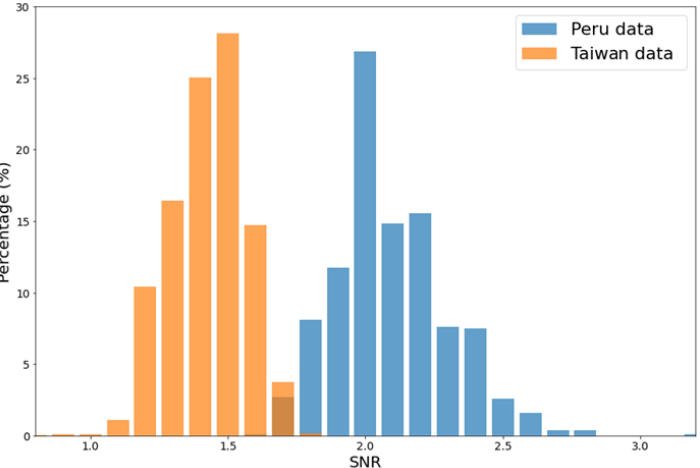
Figure 4. The histograms of the SNR for Peru data (blue) and for Taiwan data (orange). The mean SNR for Peru data is 2.09, and that for Taiwan data is 1.43, as indicated in the plot.